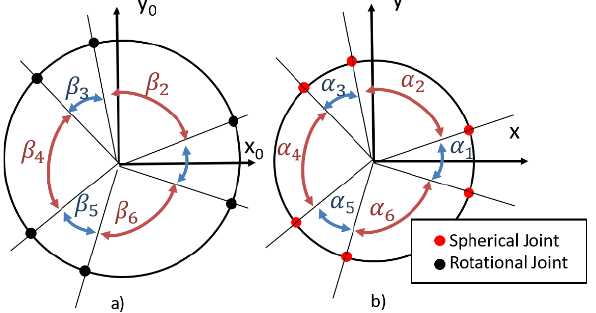
Figure 4. The fixed ( a ) and mobile ( b ) platforms of the parallel robot (adapted with permission from ref. [23]. 2022, IEEE